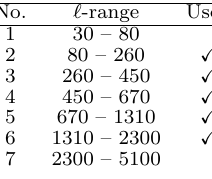
Table 2 We show the (cid:96) -bandpowers used in this analysis. The first column indicates the number of the bandpower, the second one the (cid:96) -range that each bandpower covers and the last column indicates which bandpowers were actually used to get cosmological